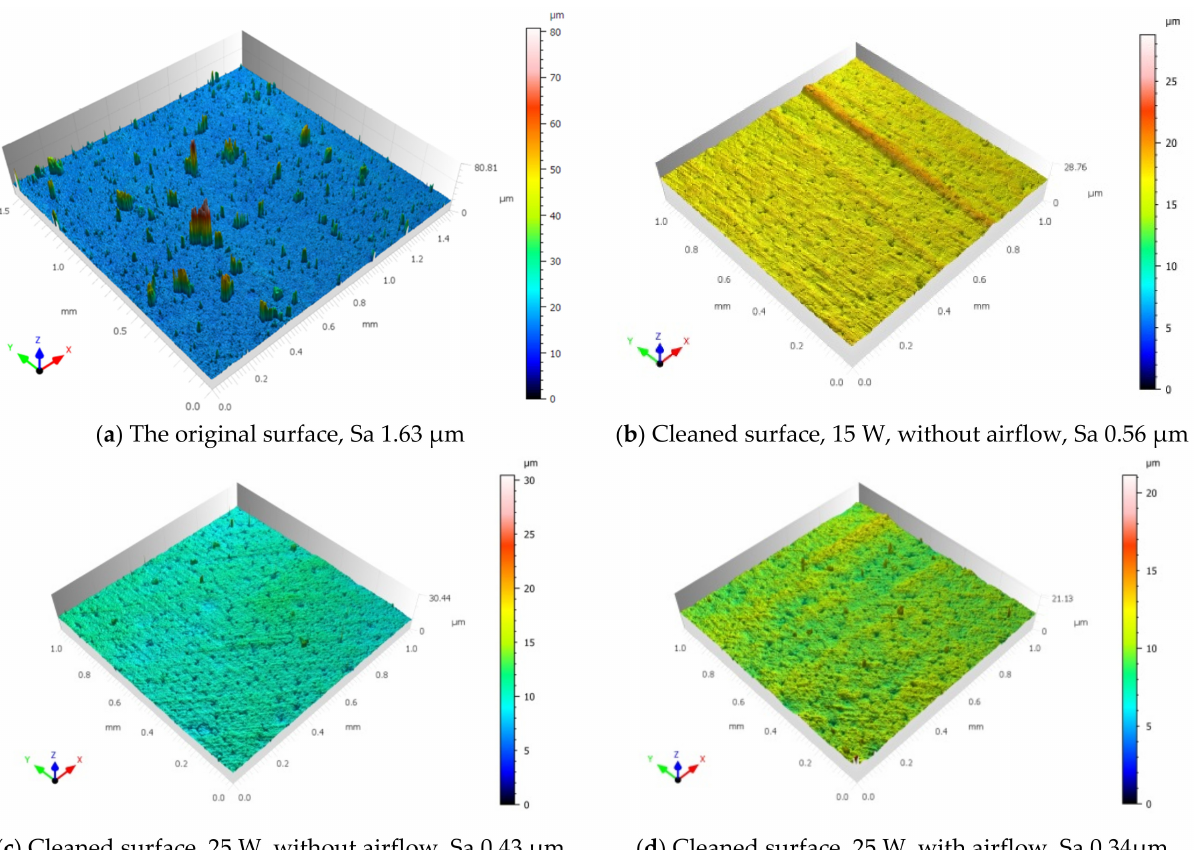
Figure 10. Three-dimensional morphology of matrix surface varying with different laser cleaning powers. ( a ) 3D roughness of original surface, ( b ) 3D roughness of cleaned surface under 15 W, without airflow, ( c ) 3D roughness of cleaned surface under 25 W, without airflow, and ( d ) 3D roughness of cleaned surface under 25 W, with